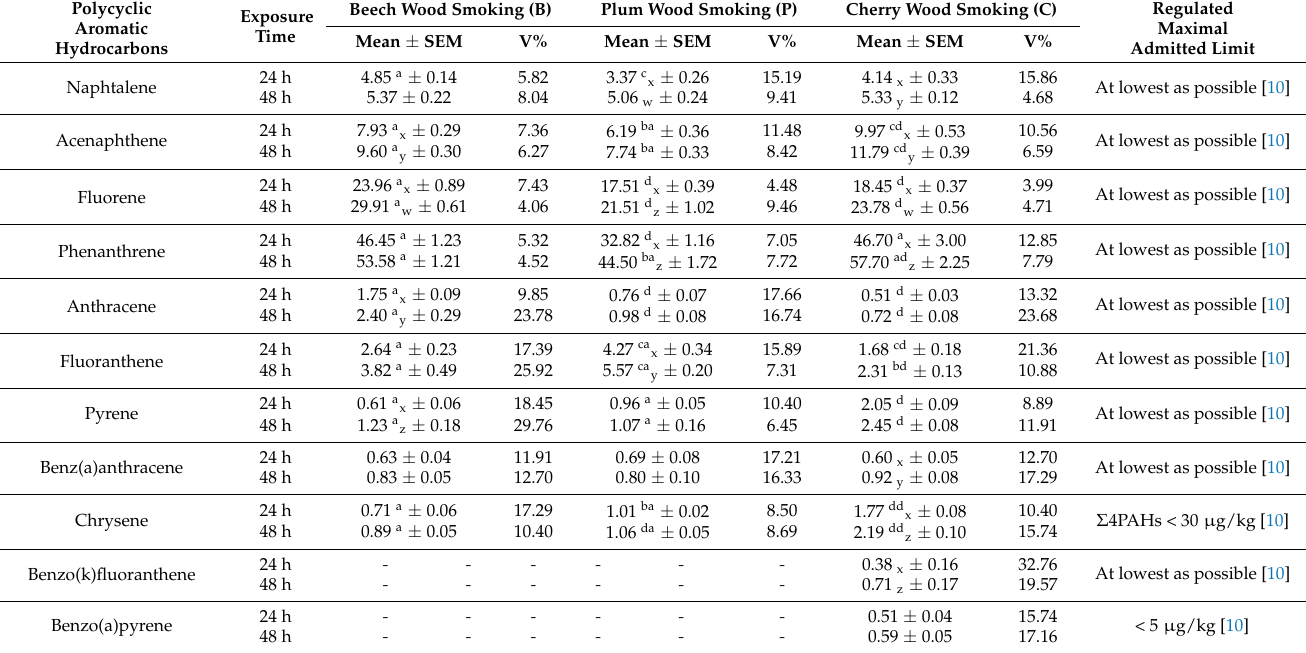
Table 3. Variance of total PAHs accumulation in turkey meat ( µ g PAH/kg meat,